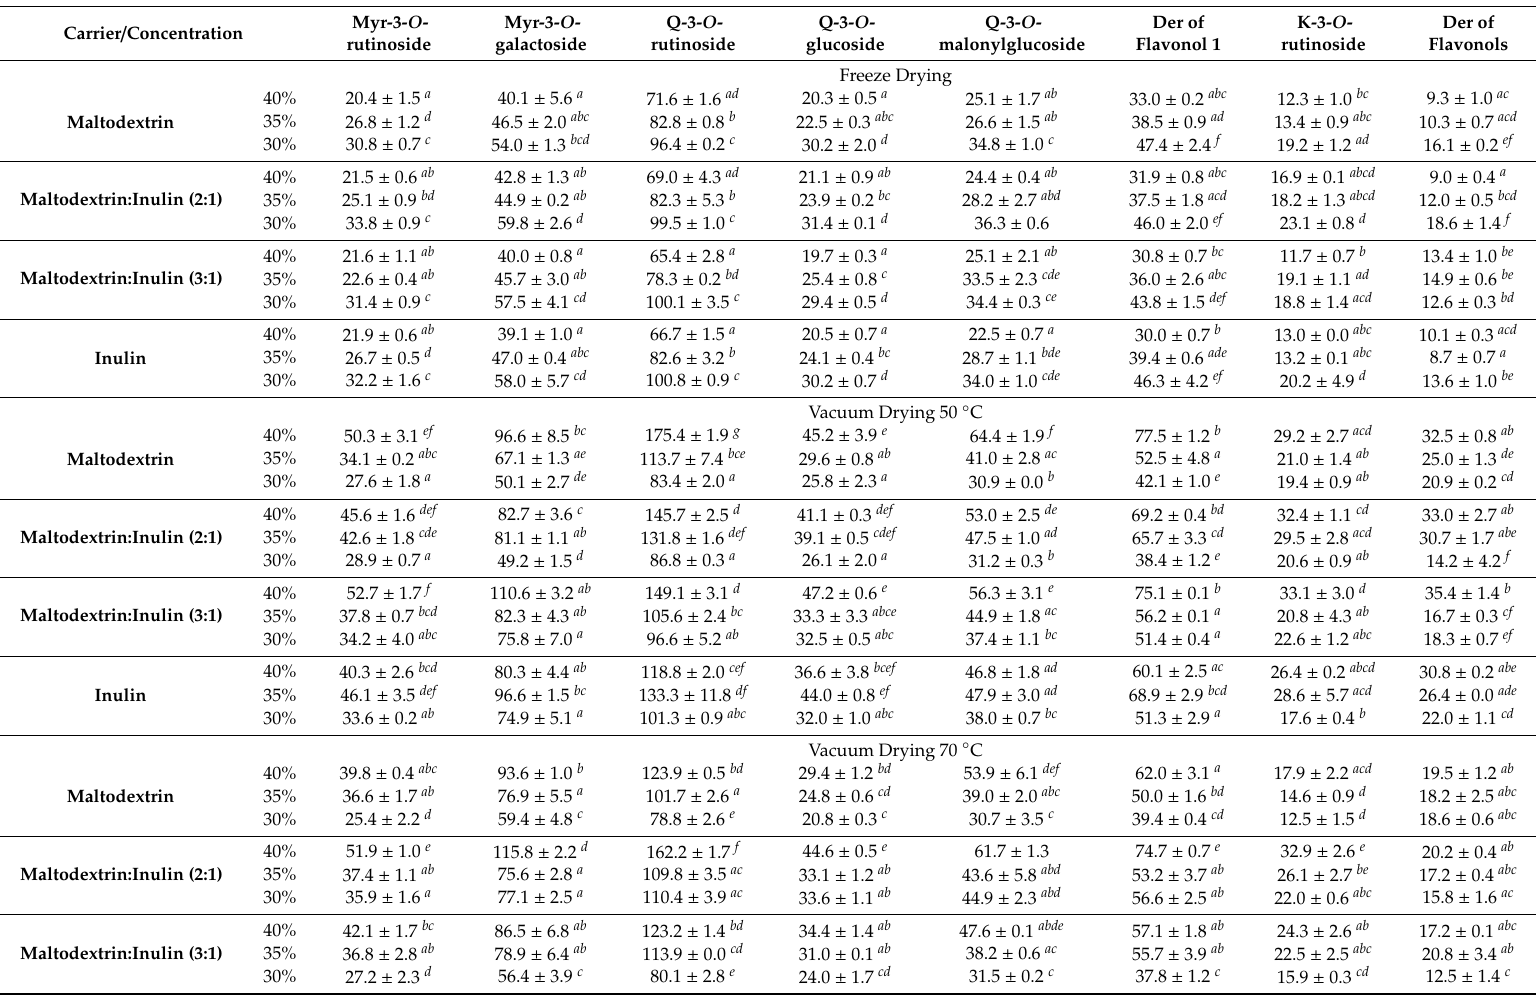
Table 2. The content of flavonols (mg / kg db) identified in blackcurrant juice powders made with the addition maltodextrin, inulin, and a mixture of maltodextrin–inulin using di ff erent drying methods (average ± SD; n =